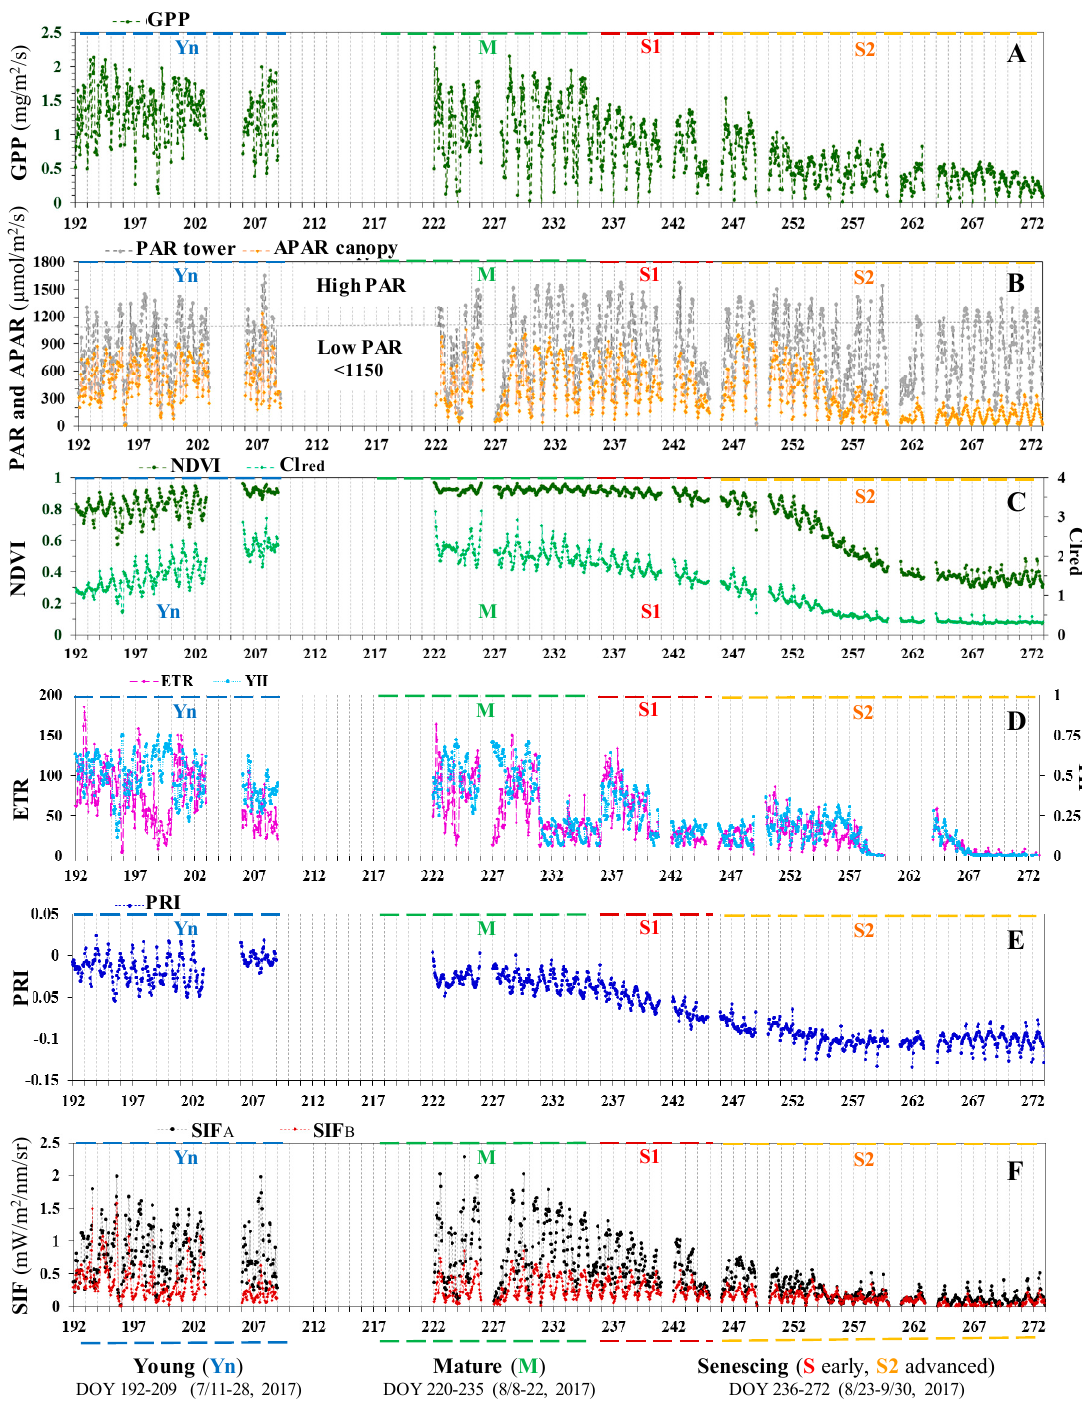
Mature ( M ) Senescing ( S early, S2 advanced) Young ( Yn ) DOY 220-235 (8/8-22, 2017) DOY 236-272 (8/23-9/30, 2017) DOY 192-209 (7/11-28, 2017) Day of year (DOY, 2017). Figure 2. Diurnal and seasonal variations in canopy gross primary production (GPP, A), incident and absorbed photosynthetically active radiation (PAR and APAR, B), reflectance indices (NDVI and Cl red , C; and PRI, E), leaf-level photosynthetic parameters (YII and ETR, D), and canopy solar induced fluorescence (SIF, F). The Y axes of each panel indicate the measured parameters. The data were collected contemporaneously at time intervals ranging from 1–30 minutes, they were filtered, smoothed and interpolated to the GPP observations (i.e., 30 minutes), resulting in a set of corresponding measurements for 58 days, depicting the diurnal dynamics across the growing season.